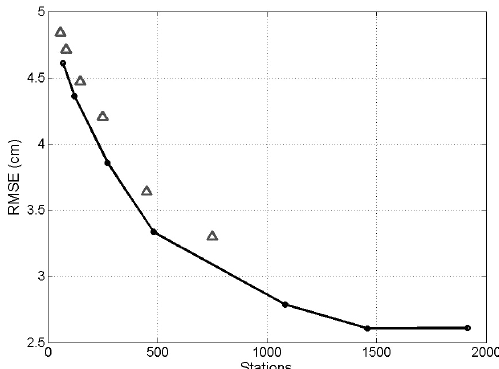
Figure 8. Root mean square errors (cm) associated with the altime- try maps recovered on 22 December 2014 from the different reg- ular sub-sampled fields mentioned in the text (black line). Trian- gles stand for the errors associated with the SLA fields retrieved for that day from the different configurations of the Argo array in the Mediterranean Sea (see Fig. 6). Notice that an Argo array con- figuration with 750 floats has been also included for comparison